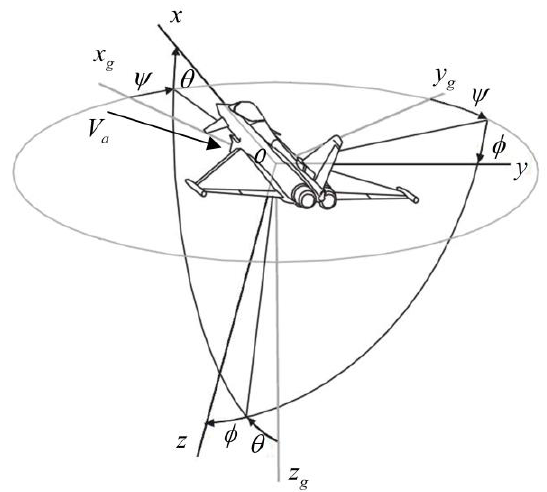
Figure 1. Coordinate systems of the aircraft.